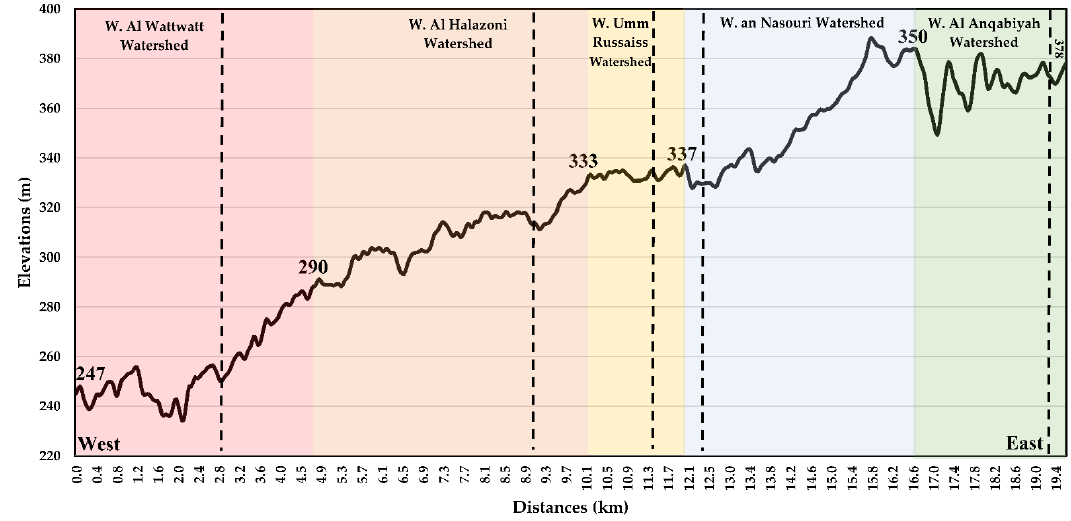
Figure 10. East–west variation of topography across watersheds in the study area (the vertical dashed lines represent the locations of the main valleys in watersheds).